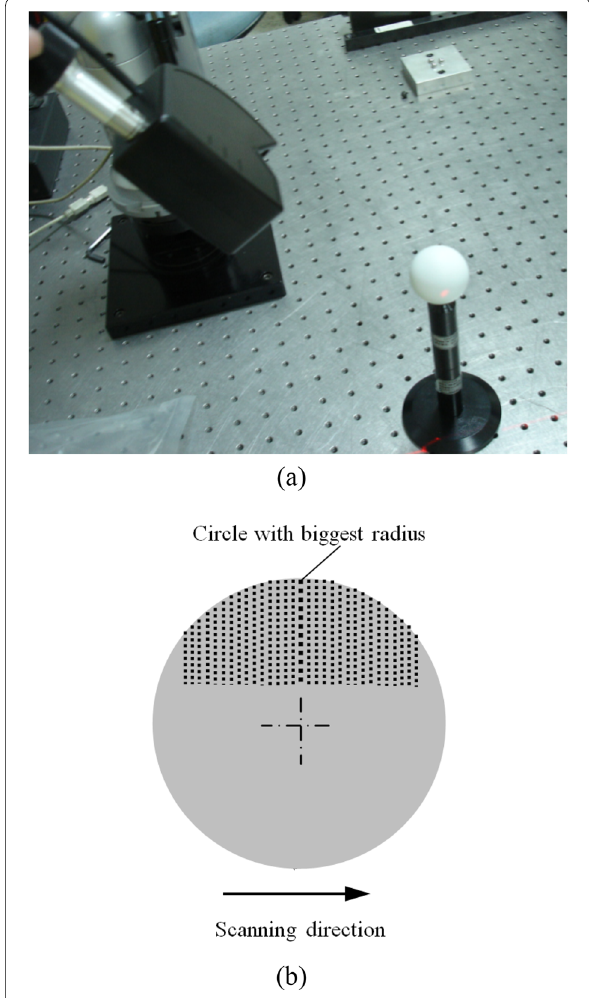
Figure 3 ( a ) Scanning a sphere and fitting circle using the 2D points on the laser line, ( b ) Center of the circle with biggest radius correspongding to the center of the